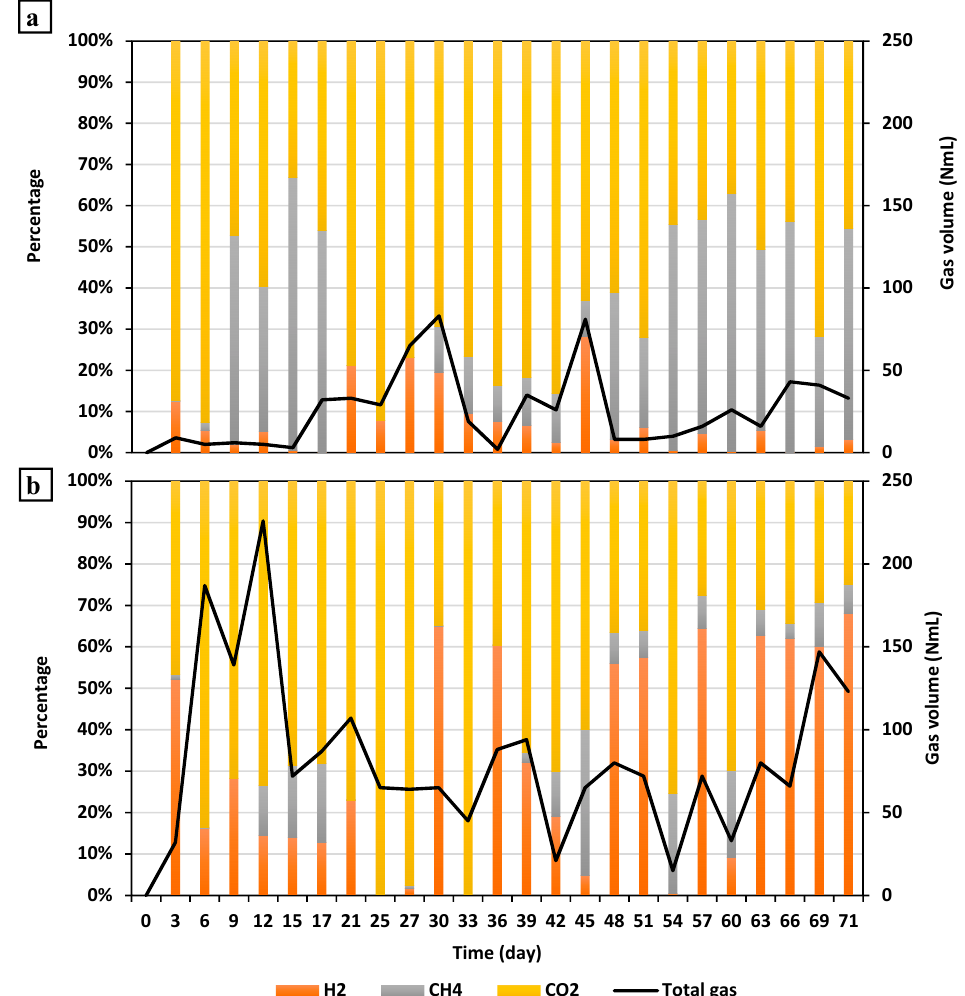
Figure 11 . Composition and volume of gas produced from ( a ) excess sewage sludge and ( b ) food waste slurry.